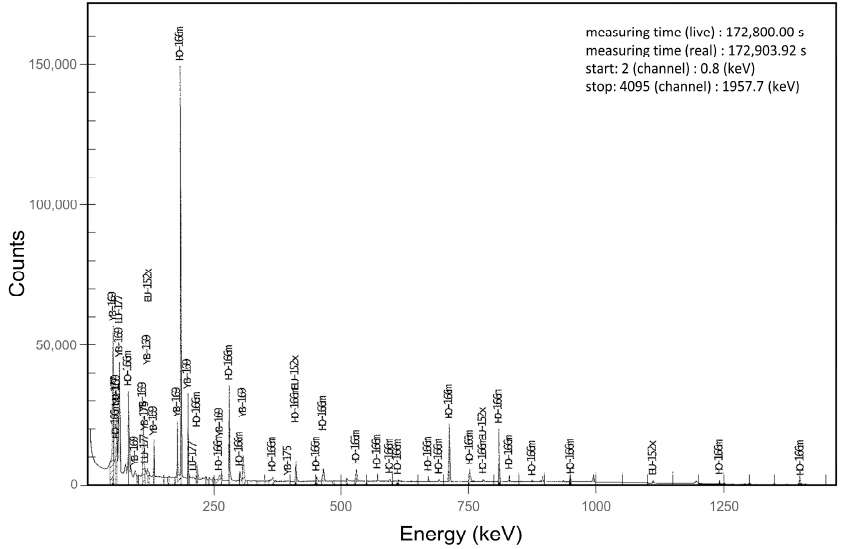
Figure 3. Energy spectrum of a 10 MBq sample of the 166 Ho chloride calibration solution after